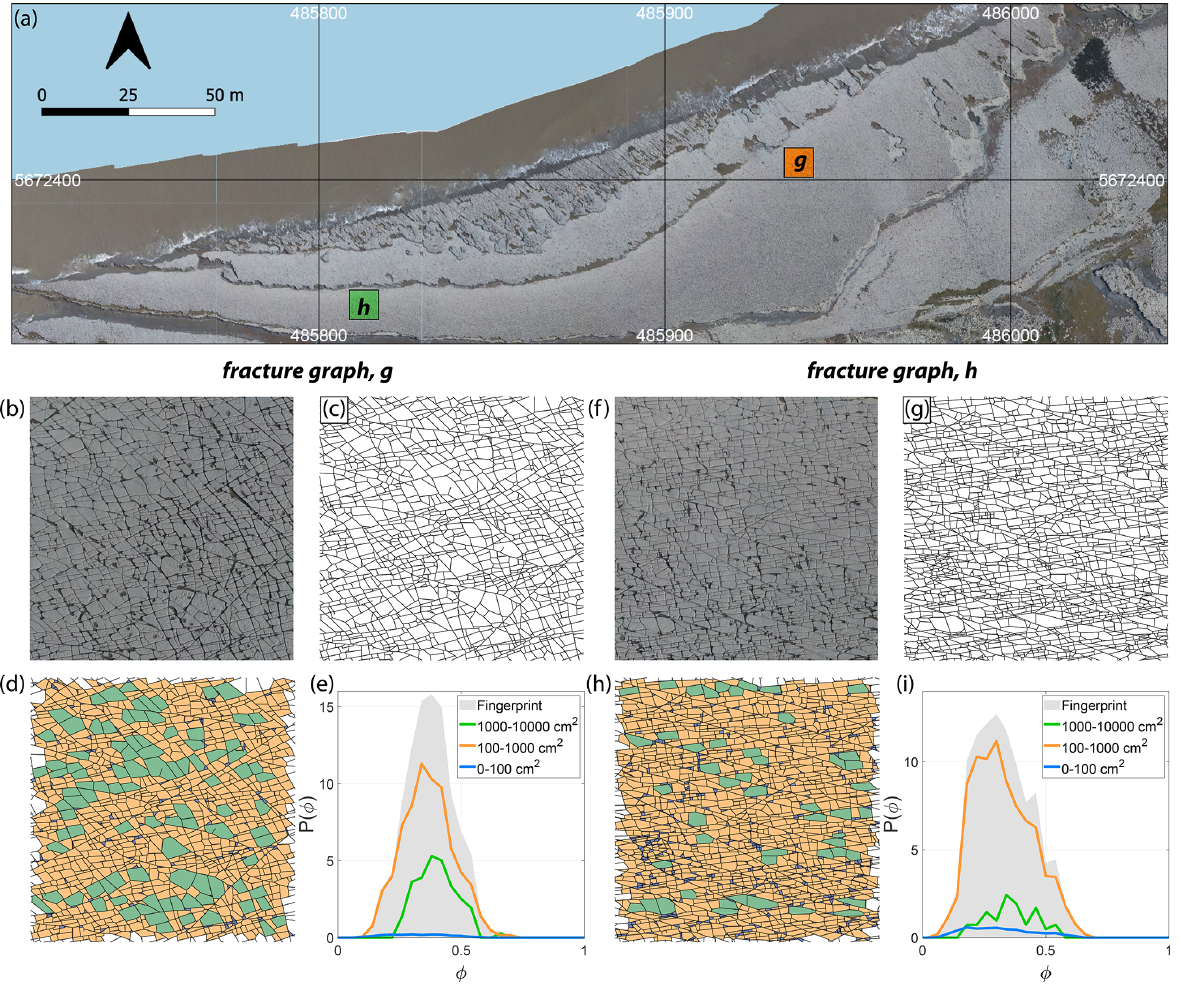
Figure 11. (a) Overview of Region 1 with two selected 1000 × 1000pixel image tiles, (b) enlarged view of first image tile, (c) fracture network corresponding to first tile as a spatial graph with dimensions of 8 . 6m × 6 . 75m and having 3583 edges and 2382 nodes, (d) block- face areas coloured as per three area bins (0–100, 100–1000, and 1000–10000cm 2 ), (e) P(φ) or fingerprint of the subgraph depicting the combined effects of area and shape factor, φ pertaining to the three area bins. (f) Enlarged view of second image tile, (g) fracture network corresponding to second image tile as a spatial graph with 5418 edges and 3539 nodes, (h) block-face areas binned logarithmically, and (i) fingerprint of second spatial graph. Panels (a, b) , and (f) are derived from images contained in the open dataset (CC-BY license) published by Weismüller et al.